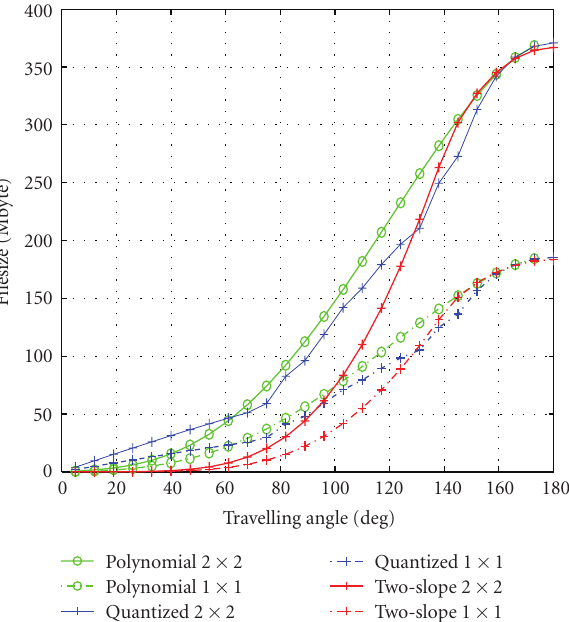
Figure 6: Comparison between theoretical and two proposed models.